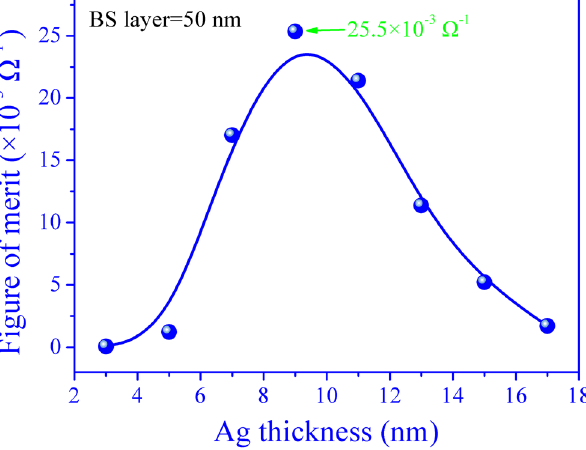
Figure 4. The FOM values of the BS/Ag/BS multilayer flexible thin films as a function of Ag